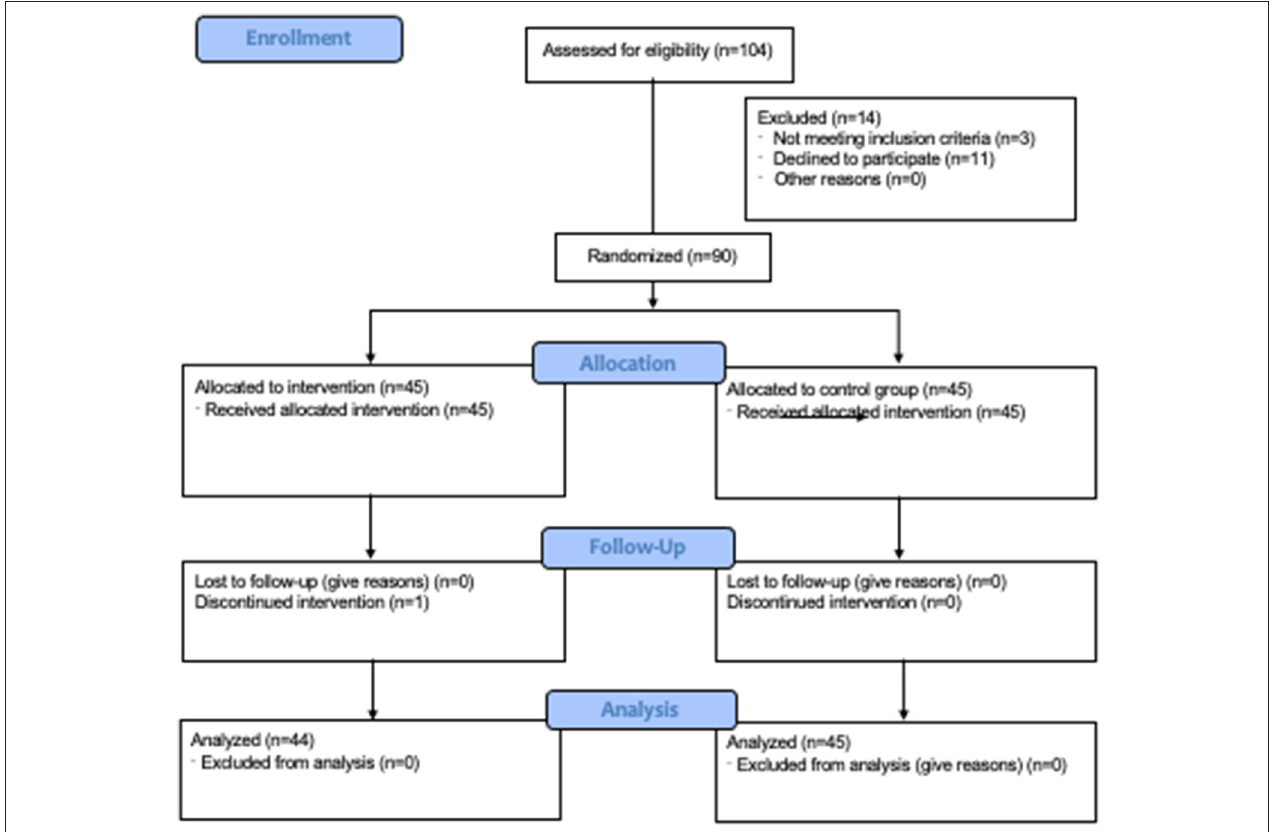
FIGURE 1 | Consort 2010 flow diagram of the